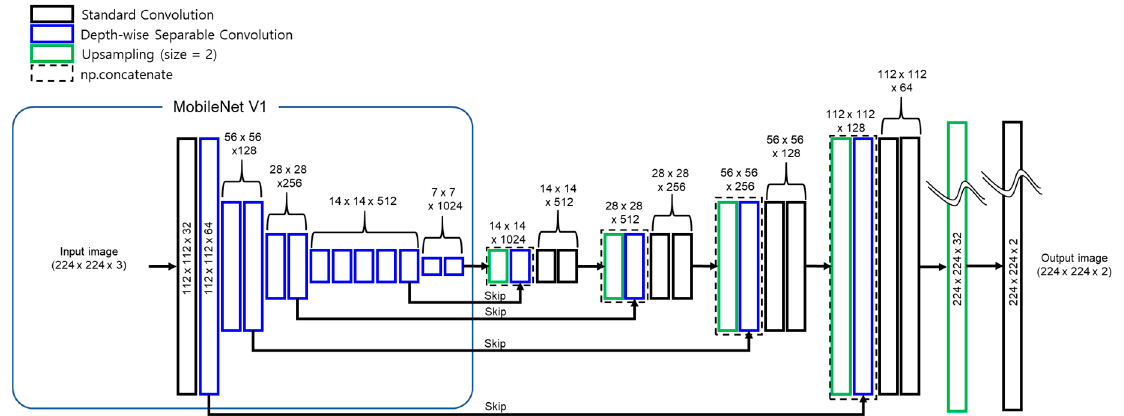
Figure 3. Model architecture of UNet.